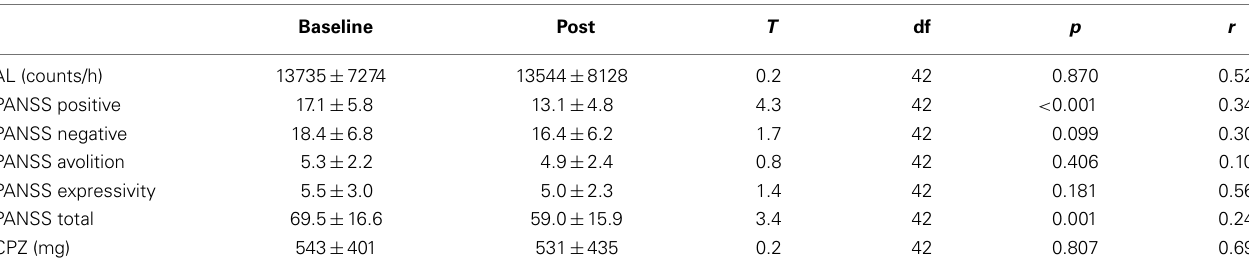
Table 1 | Paired T -tests within episode .